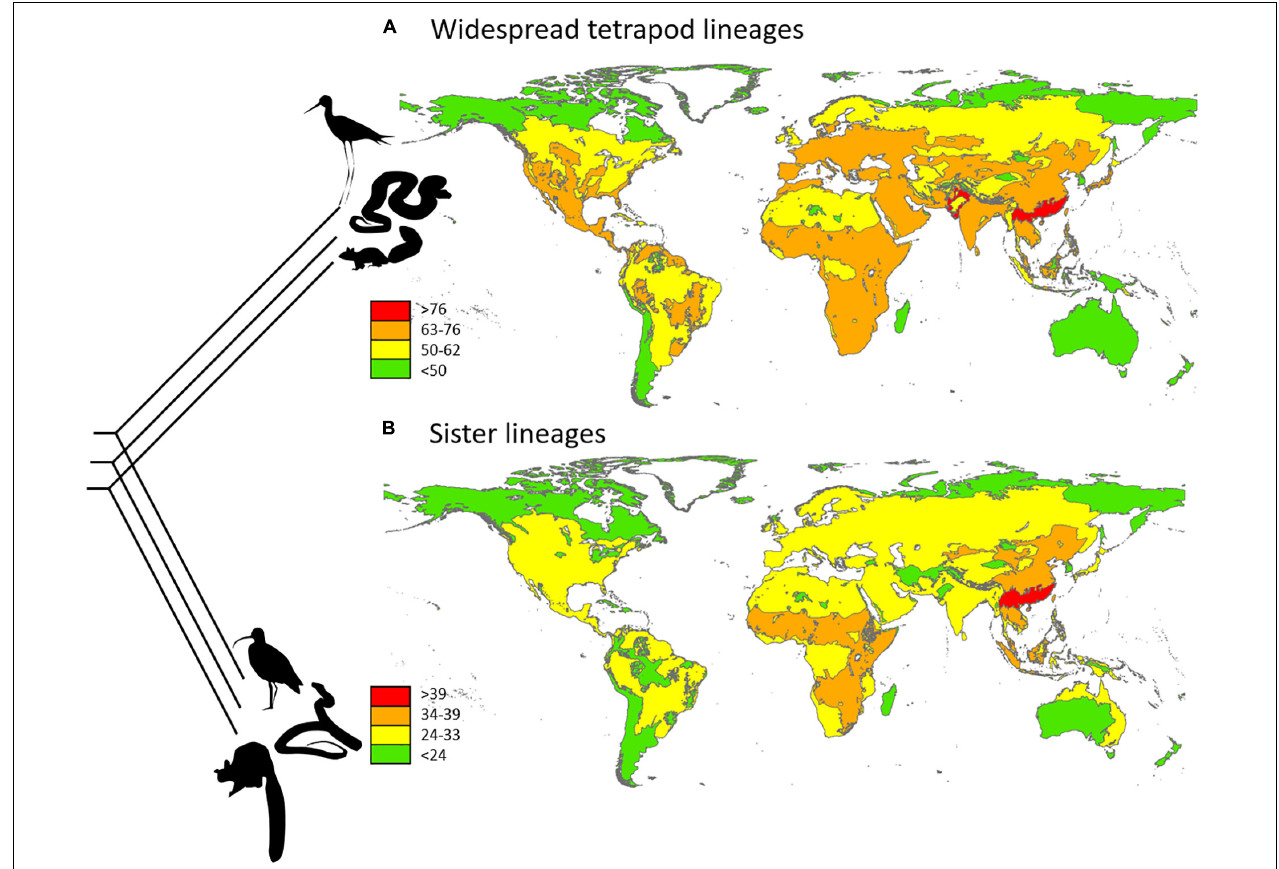
FIGURE 2 | Global diversity maps for (A) widespread tetrapod lineages and (B) their sister lineages. Redrawn from Proche¸s and Ramdhani